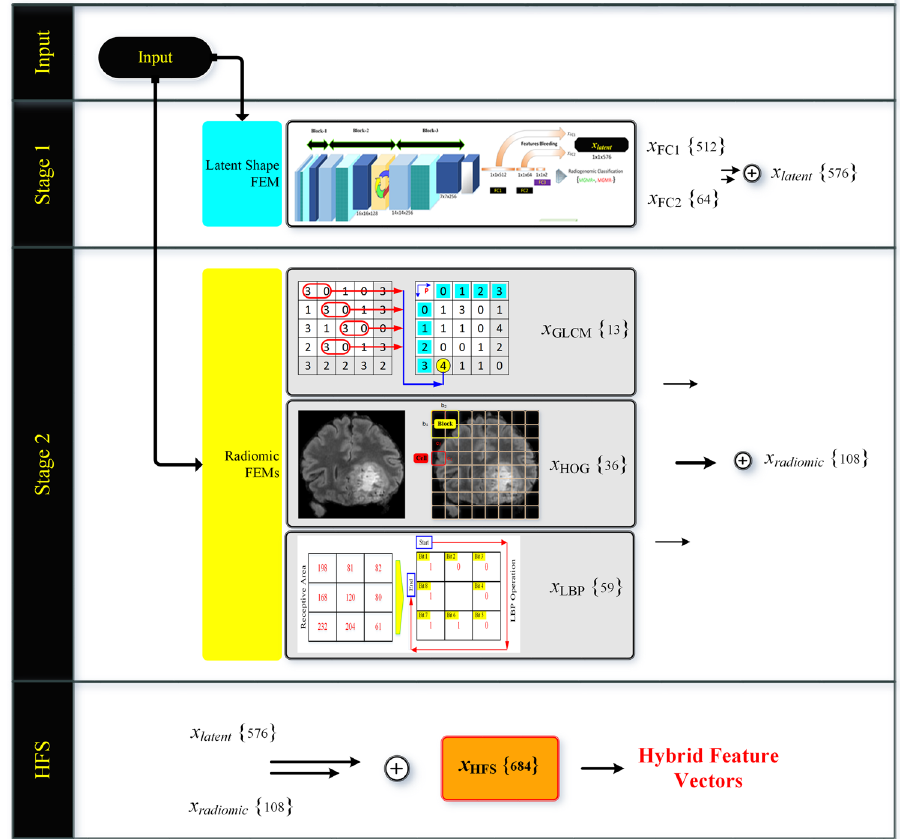
Figure 16. Schematic diagram of multi-omics HFS formation for the proposed classification framework.